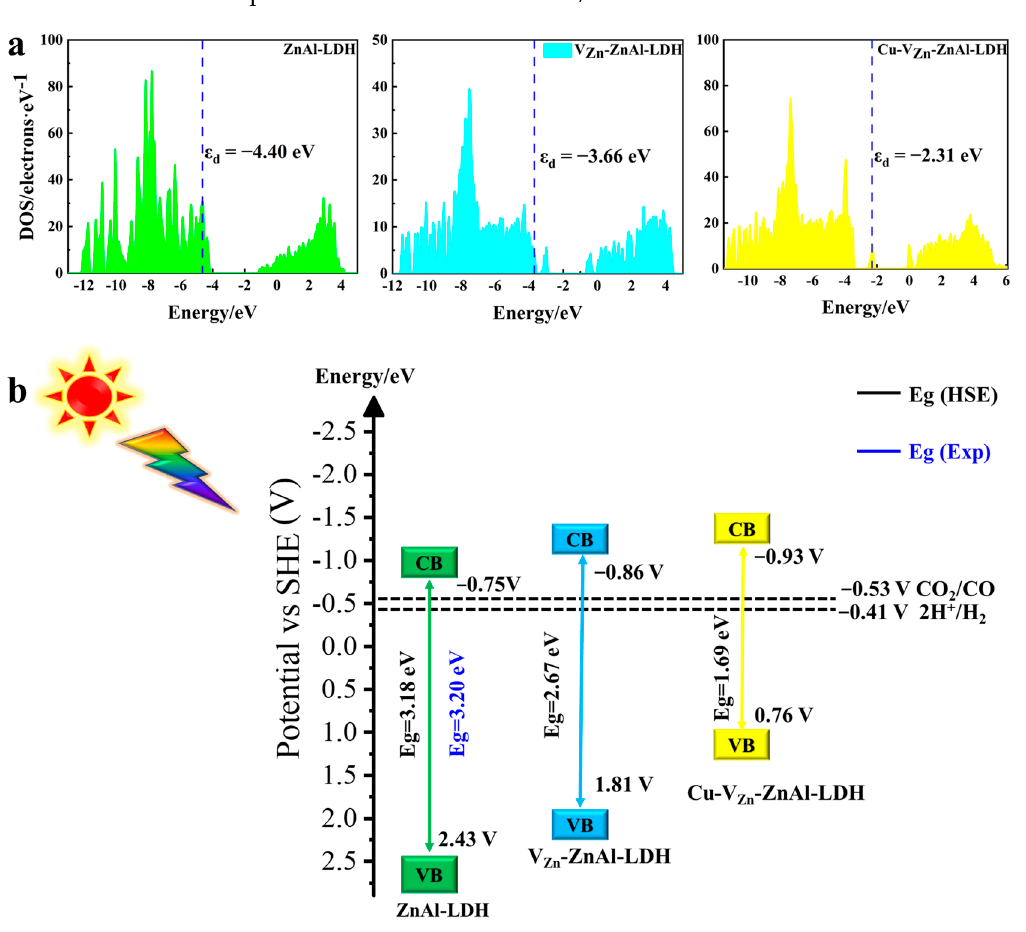
Figure 9. ( a ) The d-band center positions and ( b ) the CB and VB potentials of the three ZnAl-LDHs.